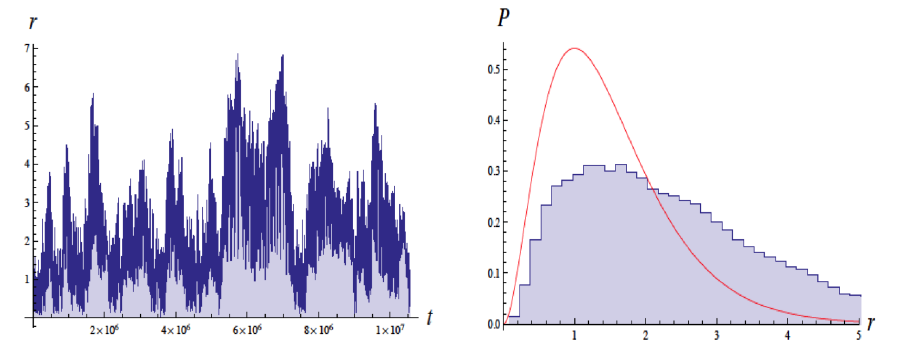
Figure 5. Plots of the radius r of the electron orbit as a function of time in units of t 0 (left side) and a histogram of r (right side), for the same simulation as Figure 4. The smooth curve is the probability distribution expected from quantum mechanics. Figure from [4] with permission.